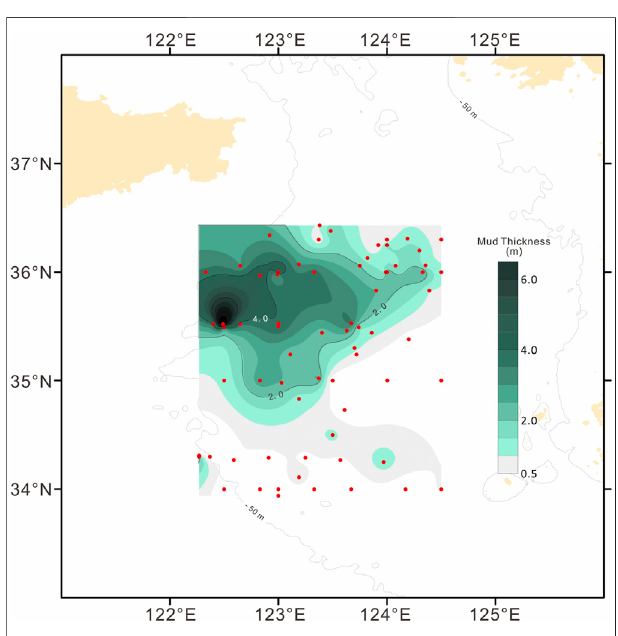
FIGURE 3 | Isopach map of mud thicknesses in the CYSM zone since 7